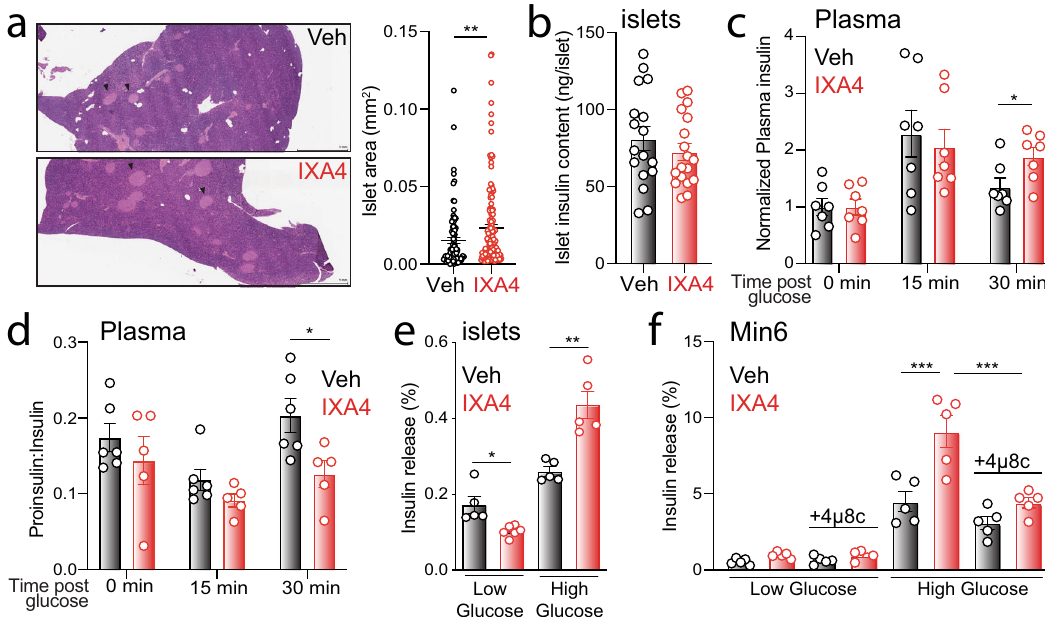
Fig. 4 IXA4 treatment enhances pancreatic function. a Representative images and quanti fi cation of islet area in the pancreas of DIO mice treated with IXA4 for 8 weeks and stained with H&E. Arrowheads indicate individual islets. The mean islet area is shown and error bars represent SEM for n = 84 or